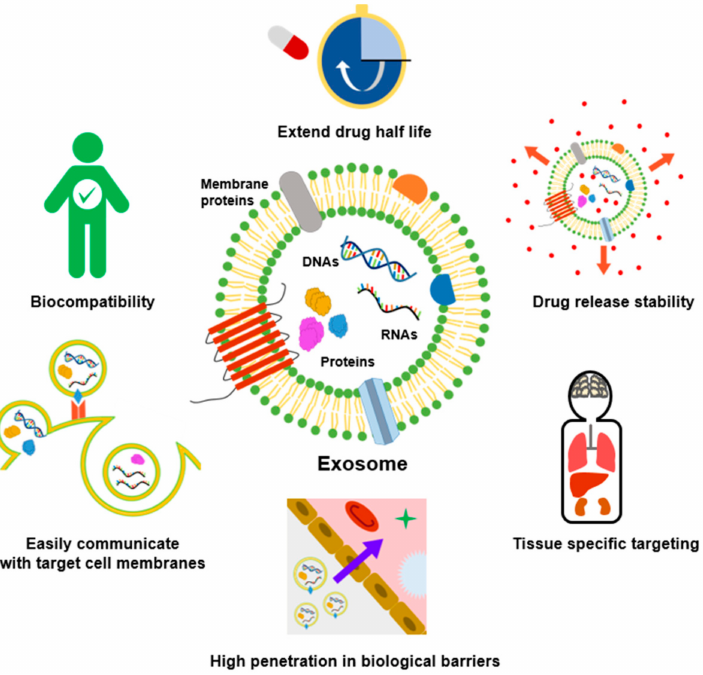
Figure 1. Advantages of exosomes in cancer treatment compared to other nanoparticles. Exosomes with lipid bilayer membrane structures encapsulate the drug inside, thereby extending drug half-life and increasing drug release stability. In addition, exosomes can easily communicate with target cell membranes and cross biological barriers such as the BBB. Due to their endogenous origin, they are highly biocompatible and can be used as nanocarriers for tissue-specific targeted delivery. Exosomes show very high cell uptake efficiency via directly interacting with the extracellular proteins or the direct membrane fusion or internalization [18]. Exosomes derived from a variety of cellular sources also carry diverse membrane proteins